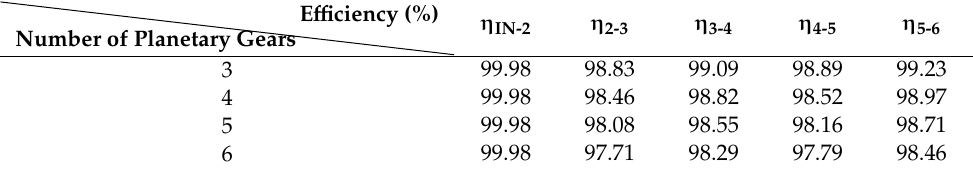
Figure 9. Flowchart of gear drive power loss calculation process. Table 4. Transmission e ffi ciency when power transmitted along the transmission